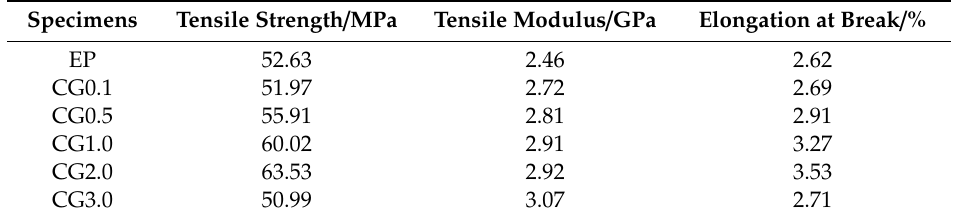
Figure 2. Tensile properties of the AMGNS-MWCNT/epoxy nanocomposites: ( a ) tensile strength; ( b ) tensile modulus; ( c ) elongation at break. Table 1. Tensile properties of AMGNS-MWCNT/epoxy nanocomposites with different AMGNS-MWCNT content.